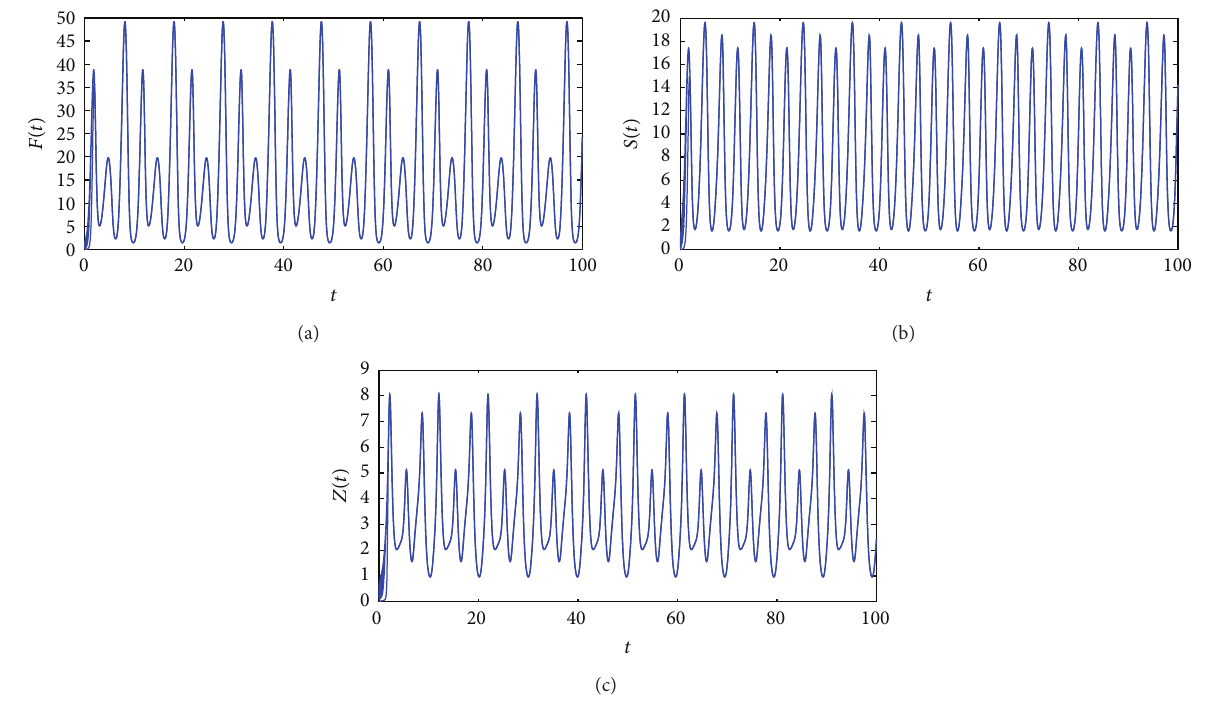
Figure 1: Permanence of system (1) with parameters in Example